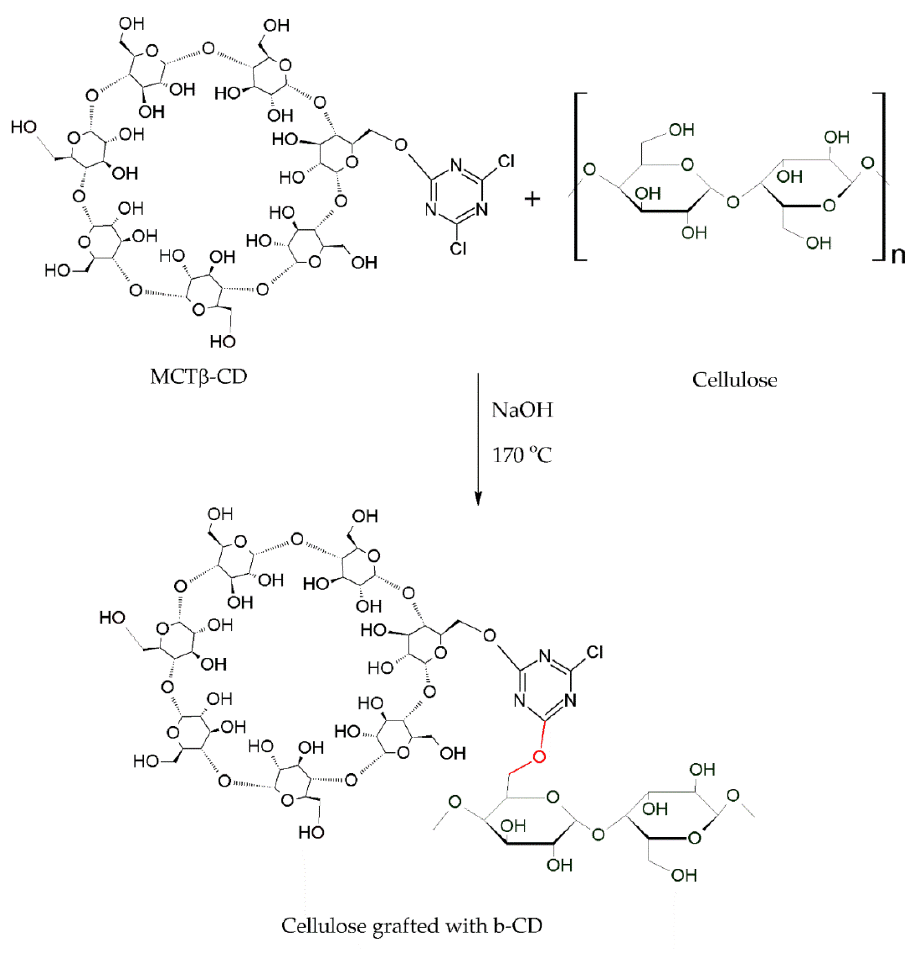
Figure 6. Nucleophilic substitution reaction of MCT-β-CD with cellulose.